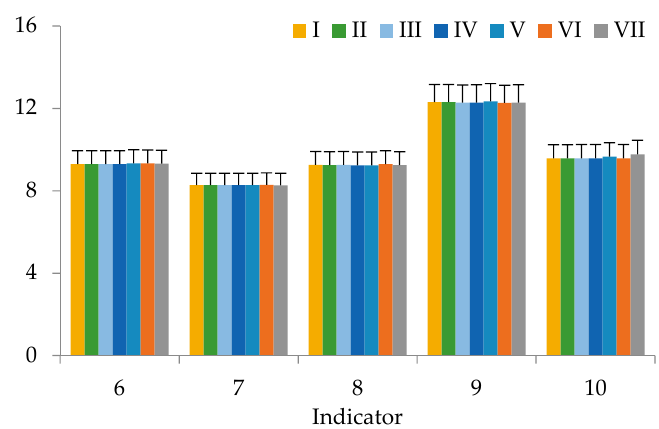
Figure 2. Biochemical and hematological indices of blood of animals from groups I–VII: 6—Urea, mmol/L; 7—ALT, U/L; 8—AST, U/L; 9—Globulins, g/L; 10—Red blood cell count, g/L; (bars in graphs indicate the SE of 15 replicates).